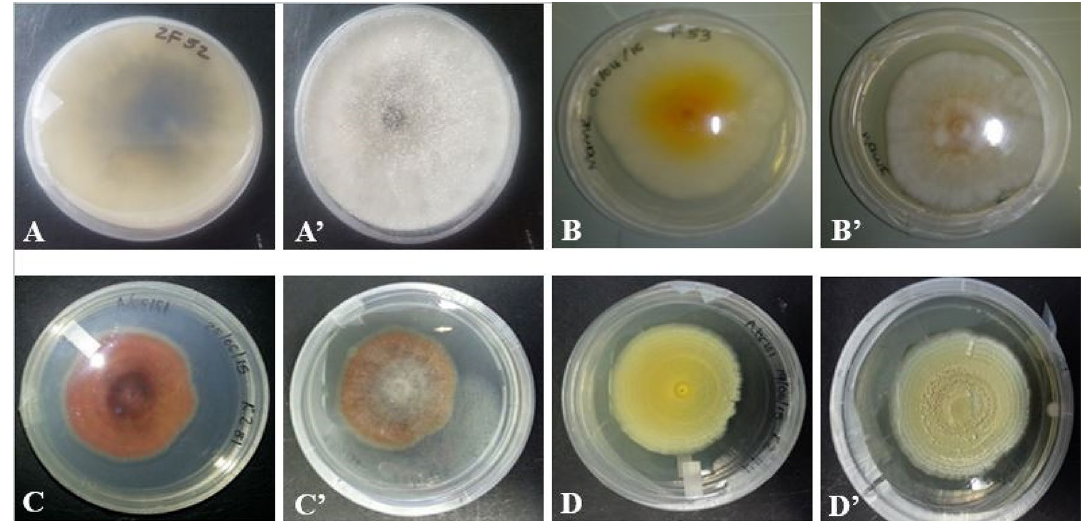
Figure 2. Growth of endophytic fungi upon resuscitation on potato dextrose agar media for four days. Top view of ZF 52, ZF 53, KZ 81 & KZ 44 are represented by ( A – D ) respectively while bottom views are represented by ( A’ – D’ ), respectively.